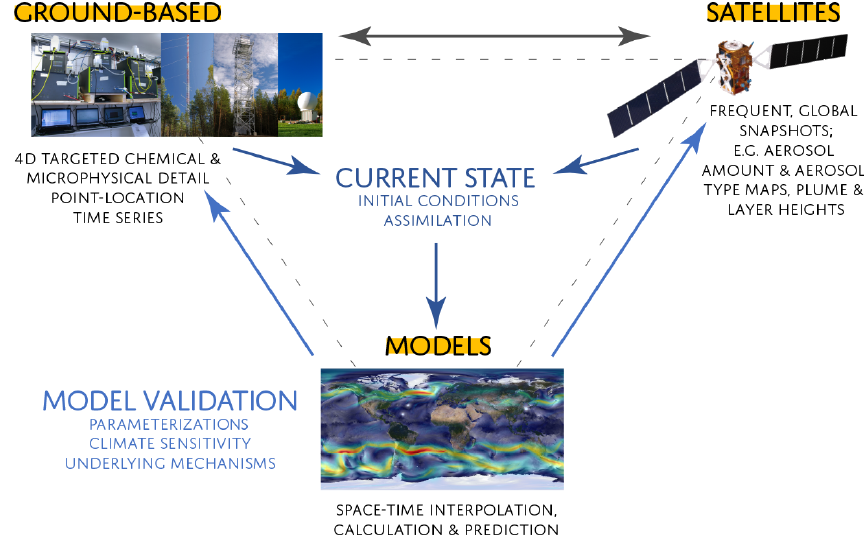
Figure 2. The integrative concept of iCUPE incorporates data and knowledge from ground-based observations, satellite remote sensing, and modeling results, providing a comprehensive view on the state of the environment in polar areas.